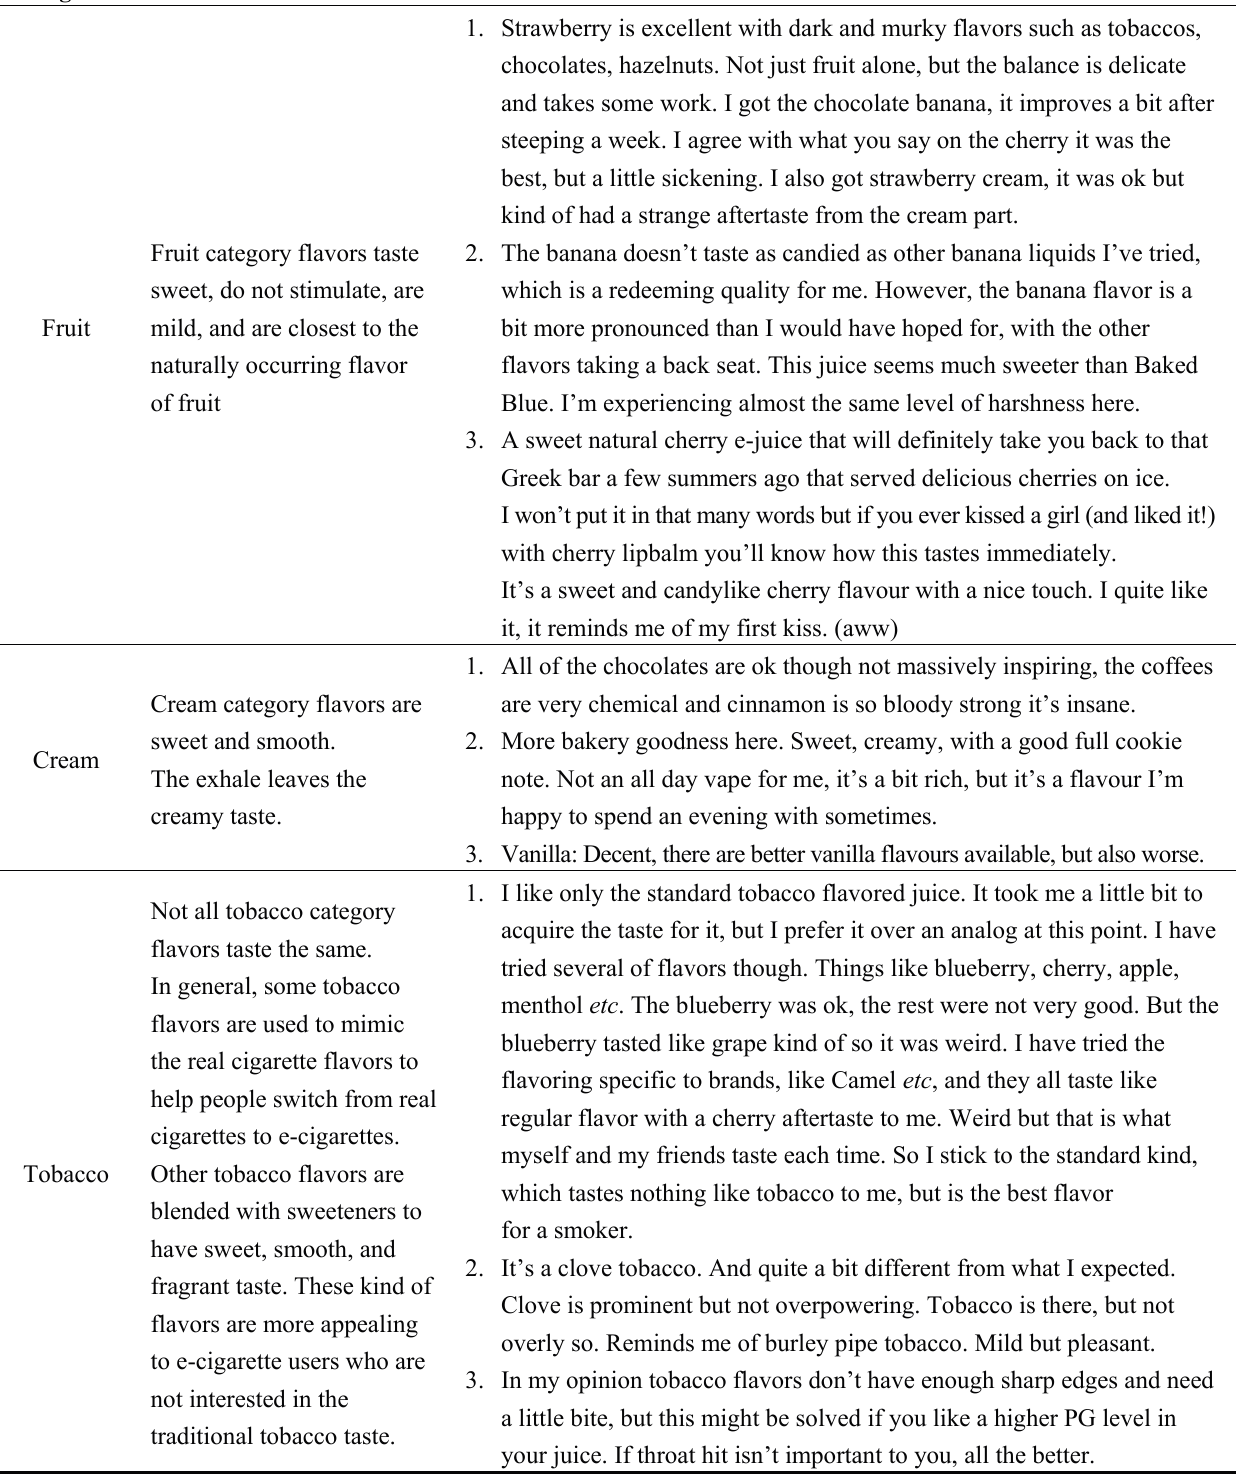
Table 1. Characteristics of